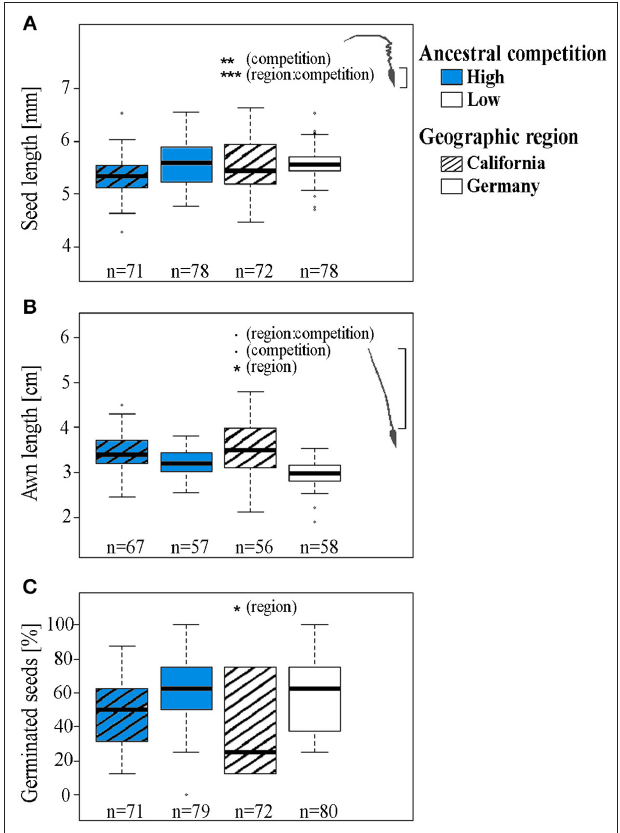
FIGURE 1 | (A) Seed length, (B) awn length (moistened, extended), and (C) proportion of germinated seeds from Erodium cicutarium plants (1st laboratory generation). Data for the proportion of germinated seeds were pooled for all maternal families per region prior to display. Data are shown for two geographic areas of seed origin: California, USA (hatched boxes) and Bavaria, Germany, and two levels of ancestral competition: high (blue boxes), and low. The box and whisker plots show the median (horizontal line), quartiles (boxes), 5 and 95% percentiles (whiskers), and outliers of each data set (open circles). Levels of significance: *** p < 0.001, ** p < 0.01, * p < 0.05, • p < 0.1, p > 0.01, not significant. The results of statistical analyses are displayed in Table 1